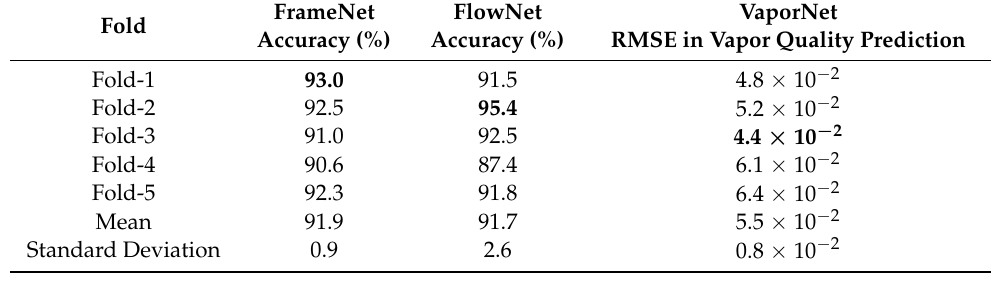
Table 2. Findings of the 5-fold test results, with best results in bold.